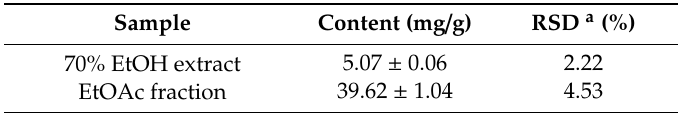
Table 5. Contents of methyl gallate in the 70% EtOH extract and EtOAc fraction from root bark of P. su ff ruticosa .